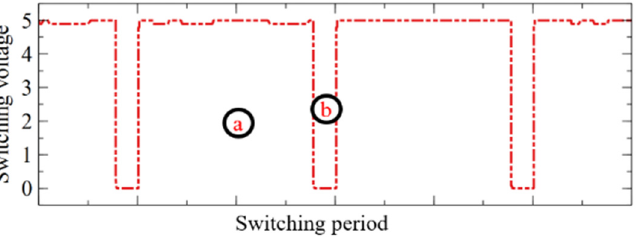
Figure 12. Applied Gate voltage to M3 waveform in the positive half cycle.